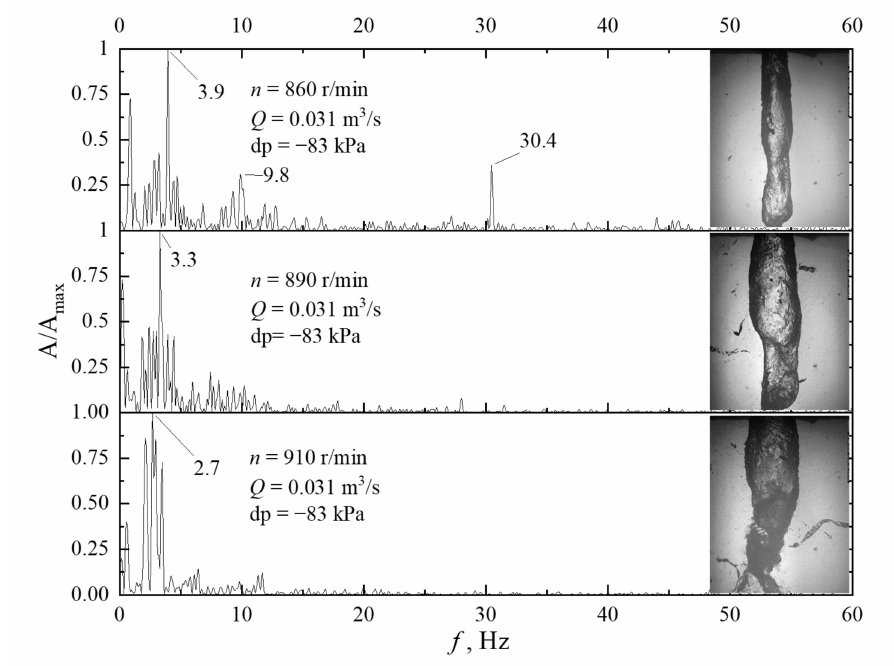
Figure 9. Pressure spectrums and flow patterns at dP = − 83 kPa for respectively ( a ) n = 860 r/min and Q = 0.031 m 3 /s ( S = 0.22); ( b ) n = 890 r/min and Q = 0.031 m 3 /s ( S = 0.29 ); and ( c ) n = 910 r/min and Q = 0.031 m 3 /s ( S = 0.34